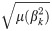
Heterogeneity of sequential effects in Operant Learning task quantified by the coefficients of a logistic regression of memory size L = 10.Panel A represents the distribution of the coefficients across participants for the bias and lags 1–4 coefficients. The statistics of these coefficients are summarized in Panel B, C and D for the mean (μ), standard deviation (μ(βk2)) and the signal to noise ratio (SNR), respectively. Error bars represents the 95% confidence intervals computed by 100-fold bootstrapping (Bonferroni corrected for multiple comparison).